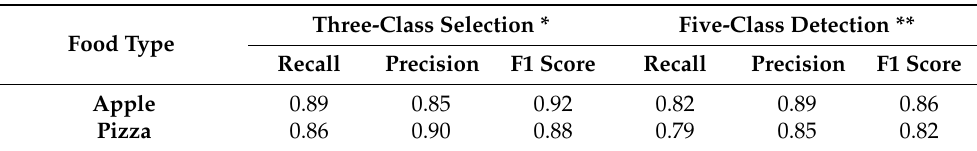
Table 7. Detection performance by food type (open food, hybrid CTC/attention model, and 10 × data